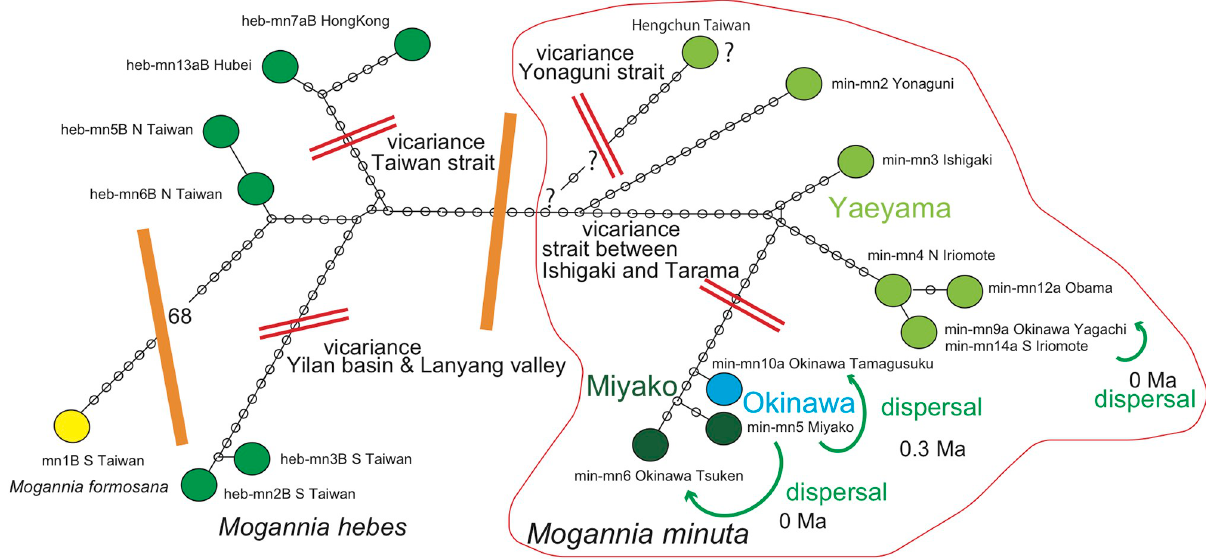
Fig 8. Haplotype network of Mogannia . On each of Yaeyama islands, Mogannia minuta constitutes the distinct haplotype, reflecting vicariant speciation since 1.55 Ma. However, this species was recently recorded from Yagachi-jima (Fig 2 inset), northern Okinawa, and the haplotype is identical to the haplotype of S (southern) Iriomote-jima, suggesting recent long-distance dispersal. The Miyako and the original southern Okinawa populations (Fig 2 inset) were included in the same Miyako haplotype network, and the southern Okinawa population originated from the Miyako population, dispersed at 0.27 Ma (Fig 6). The network of the recently recorded specimens in southern and central Okinawa such as Tsuken (Fig 2 inset) suggests recent dispersal also from the Miyako islands. Red double line: barrier for vicariance. Orange heavy line: M . hebes is separated by M . minuta , but genetically closely